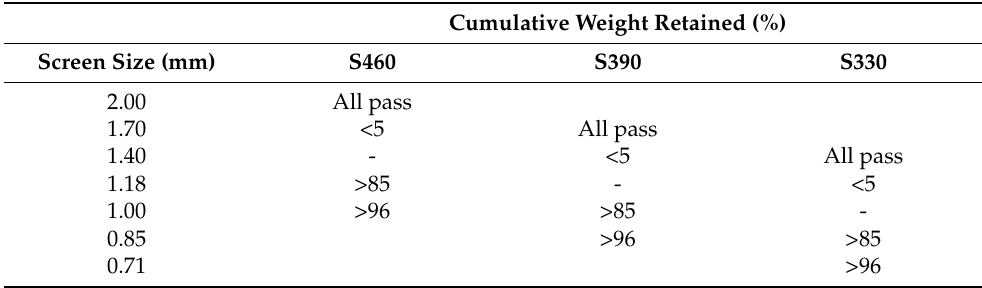
Table 2. Sieve analysis data of brand-new shots according to SAE J444 (cumulative percentage mass for each sieve level).